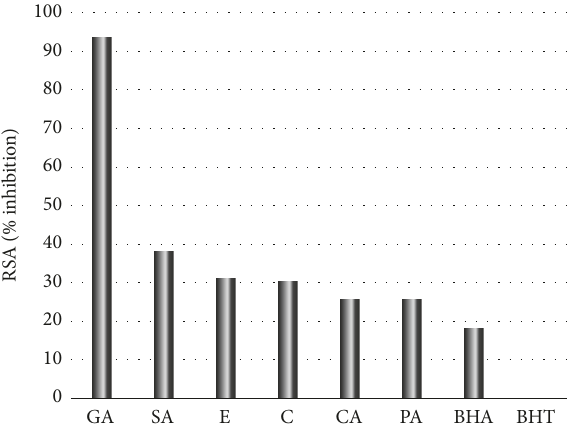
Figure 1: Relative radical scavenging activity (RSA) of pure phenolic compounds solutions at 0.1 mg mL −1